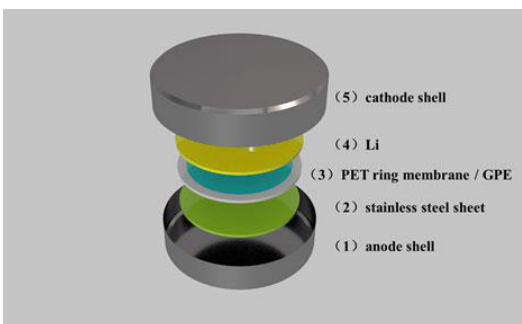
Figure 1. Structure of the stainless steel sheet/gel polymer electrolyte (GPE)/Li button battery.